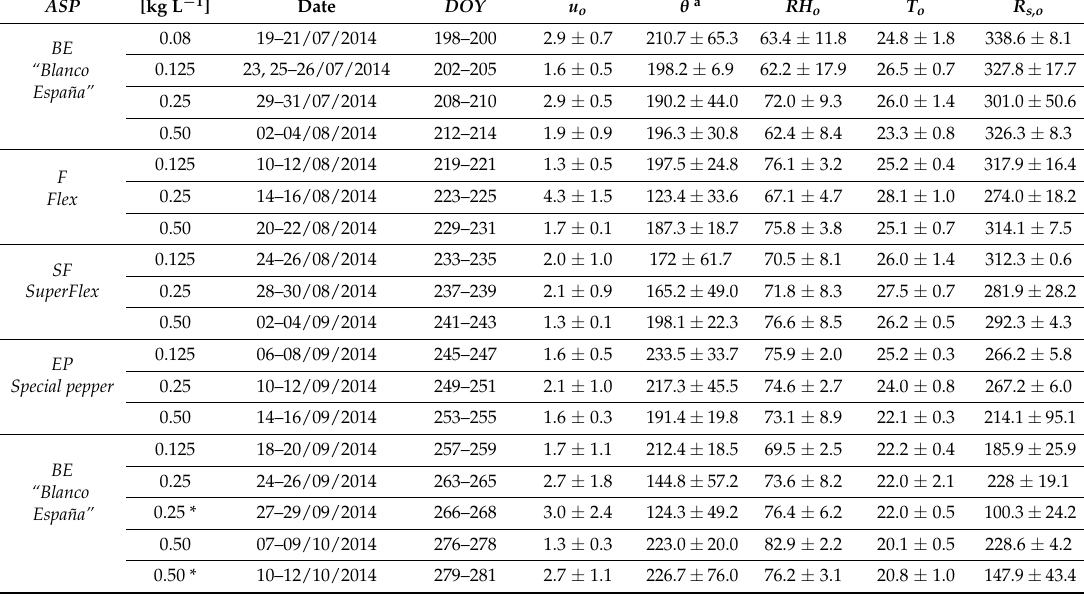
Table 1. Mean daily values of outside climatic conditions on test dates: DOY , day of year; u o , wind velocity [m s − 1 ]; θ , wind direction [ ◦ ]; RH o , relative air humidity [%]; T o , air temperature [ ◦ C]; R s,o , outside solar radiation [W m − 2